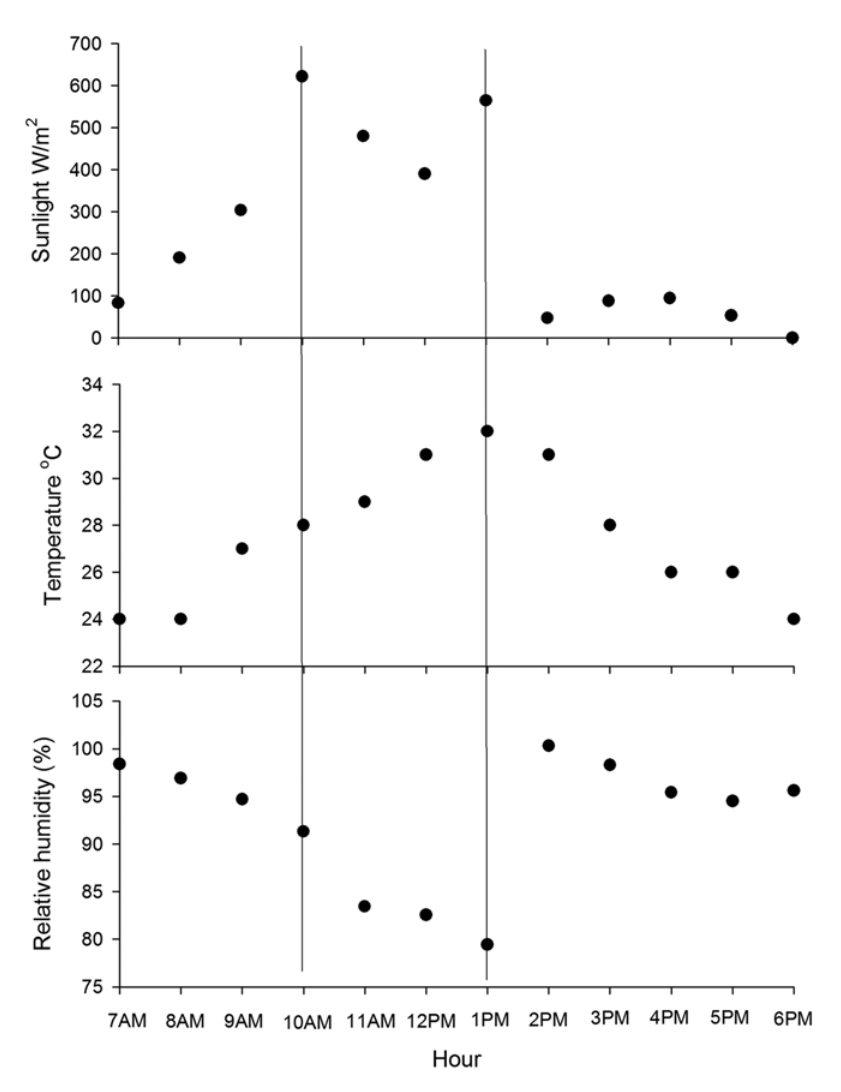
Fig. 5. Weather dynamics (sunlight, temperature and relative humidity) in an Amazonian Rain Forest fragment in Sorriso, Mato Grosso –